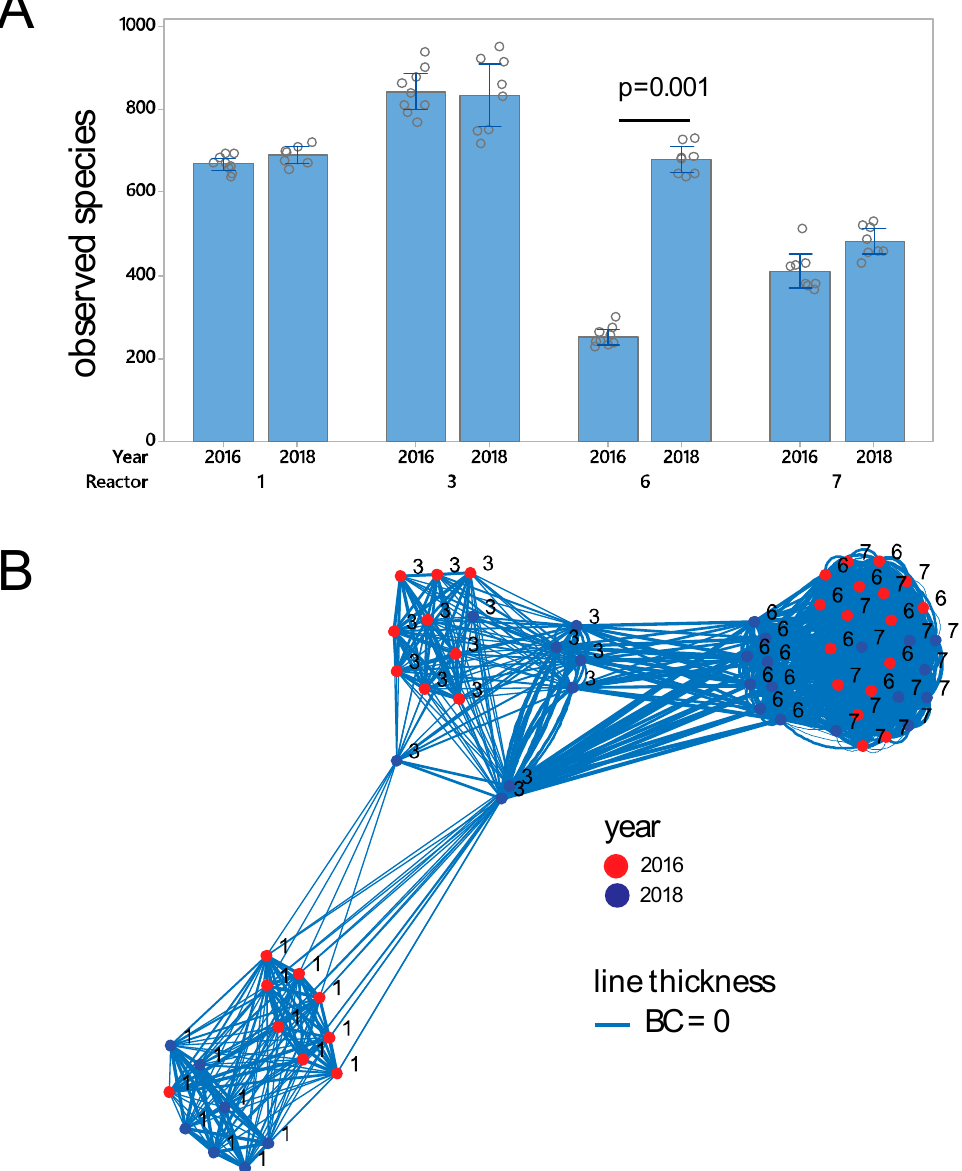
Figure 2. Prokaryote diversity measures. ( A ) α -diversity, as represented by observed species. Error bars represent standard deviations. ( B ) β -diversity, as represented by Bray–Curtis (BC) distances. Each sphere represents a biofilm. Bray–Curtis distances are represented with lines, with an inverse relation between distance and line thickness, with distances <0.5 being connected. The analyses were performed on the 66 samples with number of sequences above the rarefaction threshold of 10,000 sequences for the 16S rRNA gene. The p -value was determined by the Kruskal–Wallis test. Based on functional inference from taxonomic information in the MIDAS 2.0 database, Reactor #1 showed a high relative abundance of potential denitrifying bacteria (Supplementary Figure S2A). The highest level of nitrifiers was identified in Reactor #3 (Supplementary Figure S2B), with a